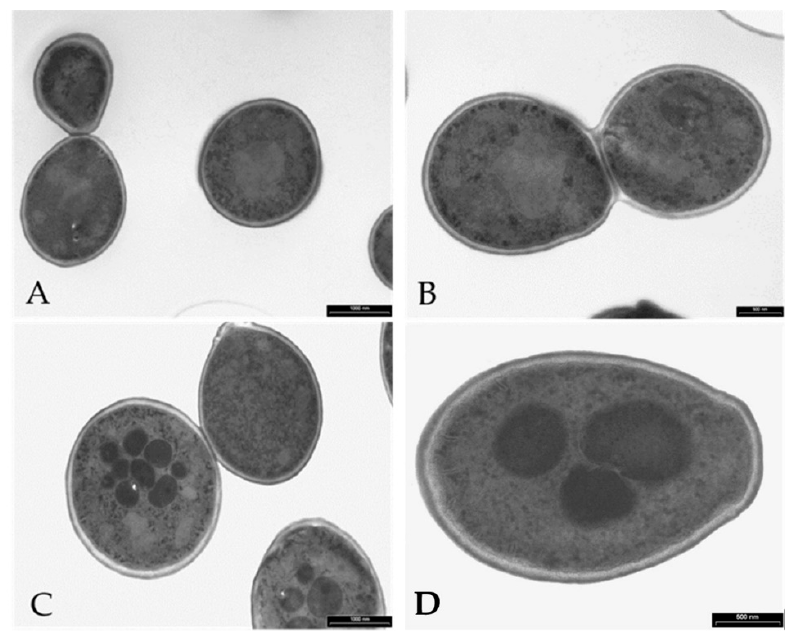
Figure 5. Transmission electron microscopy of Candida albicans cells treated with peptide K13L. Cells were incubated without (panels A and B ) or with (panels C and D ) K13L. Microbodies were seen in still intact treated cells. Bar: 1000 nm (panels A and C ), 500 nm (panels B and D ).